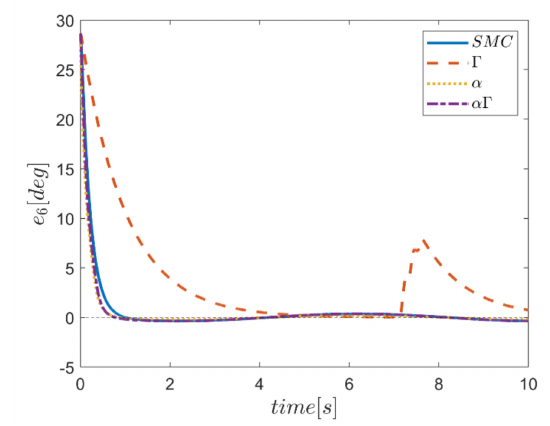
Figure 45. Tracking error in the ψ channel.